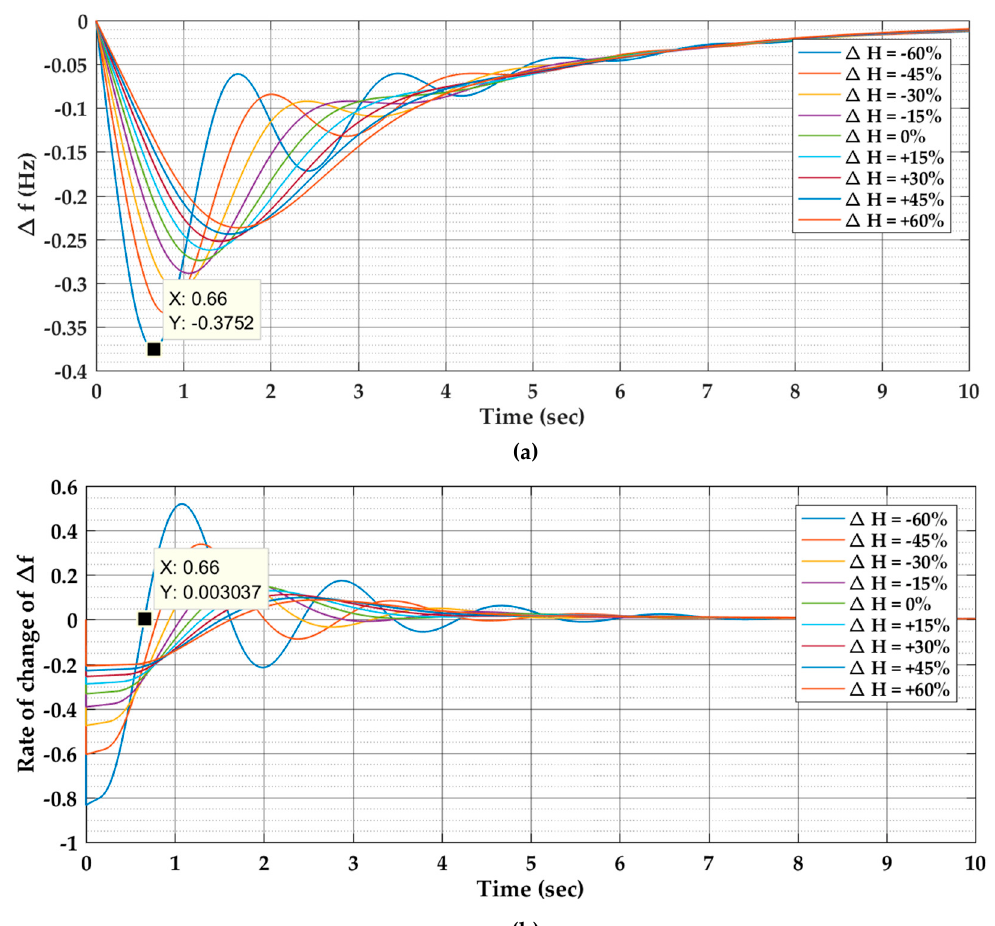
Figure 6. Effects of varying H on the PSFR for a stable power system with primary and supplementary controls. ( a ) Frequency deviation due to step load disturbance. ( b ) Rate of change of the frequency deviation.